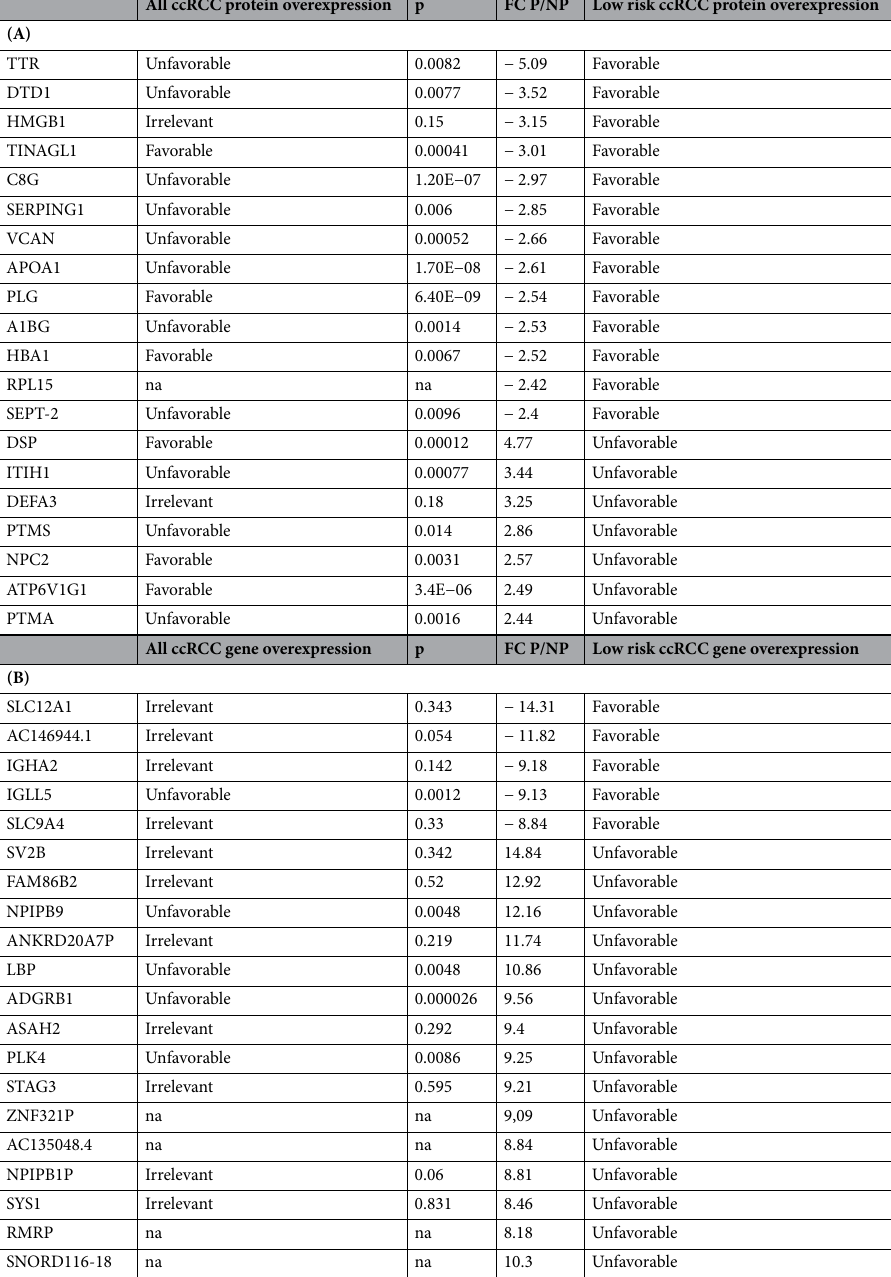
Table 3. Comparative analysis of the prognostic significance of proteins (A) and genes (B) differentially expressed in P and NP low-risk ccRCC, as detected in this multi-omics evaluation and in unselected ccRCC, based on data from The Cancer Genome Atlas as evaluated in https:// www. prote inatl as. org and https:// xenab rowser. net, respectively. The favorable and unfavorable designation relates to how the expression of a molecule was associated with a improved of diminished